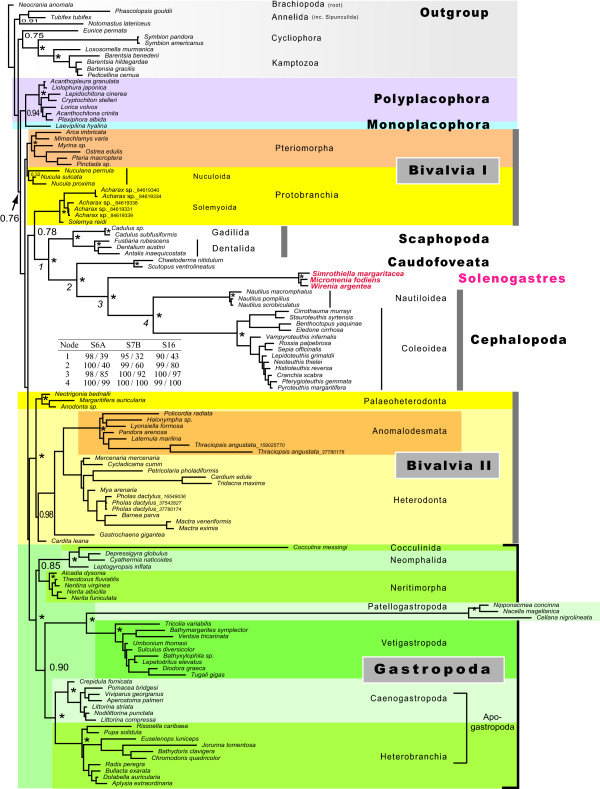
Consensus tree from the bayesian analysis using a time heterogeneous model in phase 2.0. * = indicates full support from the posterior probability (pp: 1.00). The Mollusca (pp: 0.75) and all mollusk classes (pp: 1.00) except Bivalvia were recovered. Solenogastres and Cephalopoda were assigned to different substitution models within this run. The branching pattern assembling taxa with similar sequence composition at node one to four is very robust in all analyses (see also table 2). Inserted table: ML bootstrap support (BS) is given for the nodes 1-4 using three suggested doublet models (S6A, S7B, S16). We used two different coding schemes for unpaired sites to infer the possible influence of base composition to the results. BS values are depicted in the order NT/RY: original nucleotide (NT) coded loops in followed by the results providing a recoded (G, A: R; T, C: Y) loop region.